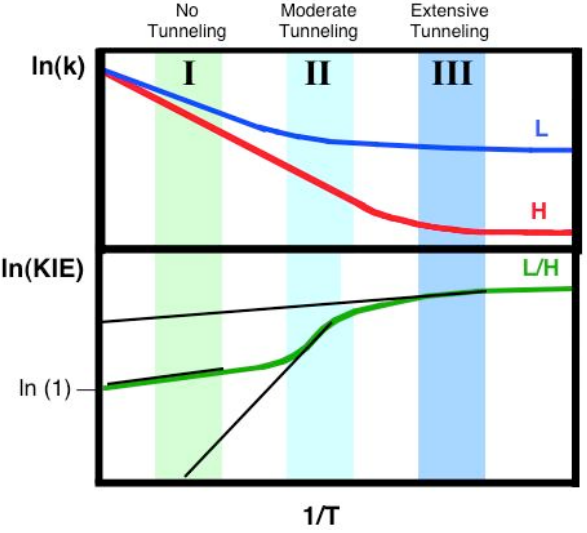
Figure 3. Arrhenius plot of rates (top panel) and KIEs (bottom panel, green line) of light (L, in blue) and heavy (H, in red) isotopes. In region I tunneling is negligible so A close to unity. Region II is the moderate tunneling region where only the lighter isotope tunnels and the corresponding A region III, making the A from ref.